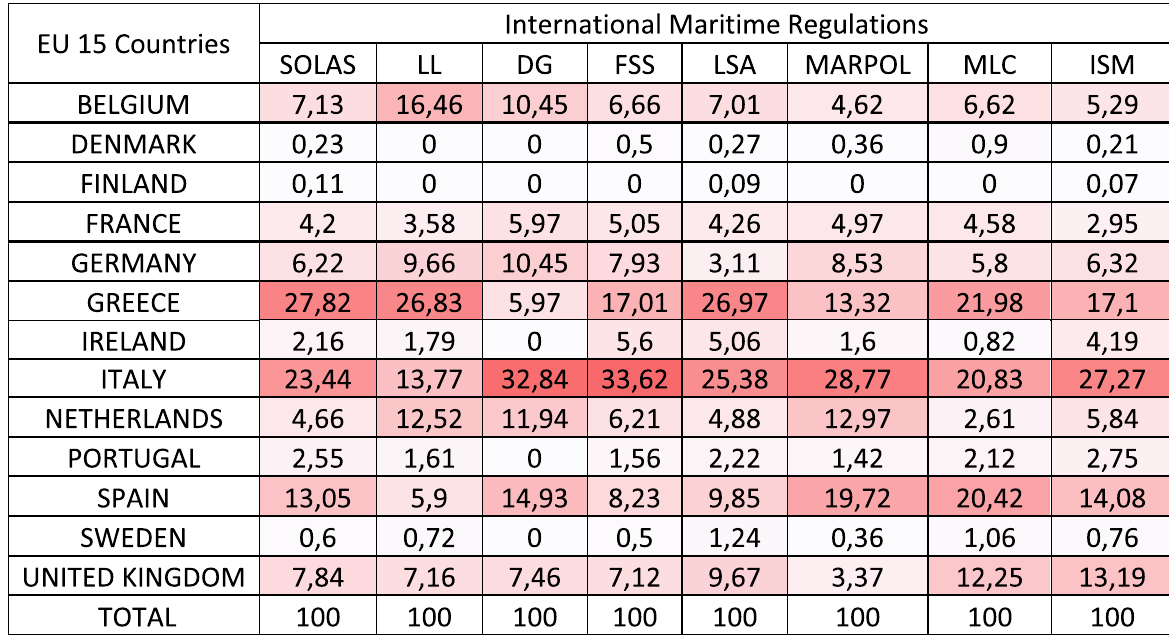
Table 3 Percentage values for each maritime regulation by EU15 countries (all values are in percentage)